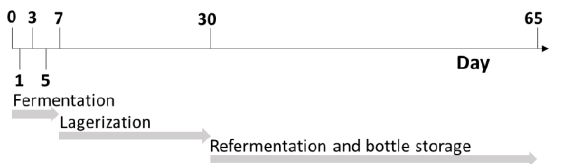
Figure 1. Schematic representation of sampling timepoints during different process stages.